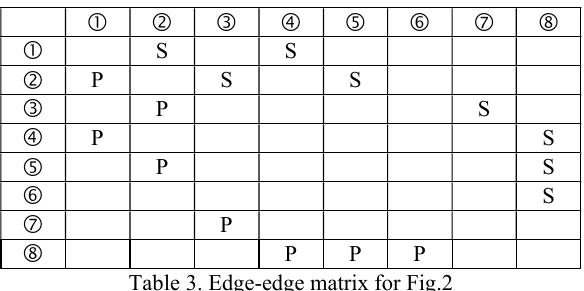
Table 3. Edge-edge matrix for